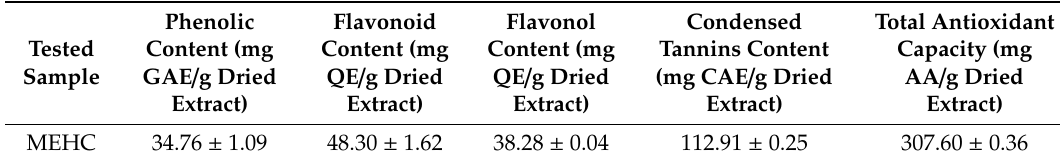
Table 2. Total phenolic, flavonoid, flavonol, condensed tannins contents, and total antioxidant capacity of the methanol extract of Holigarna caustica